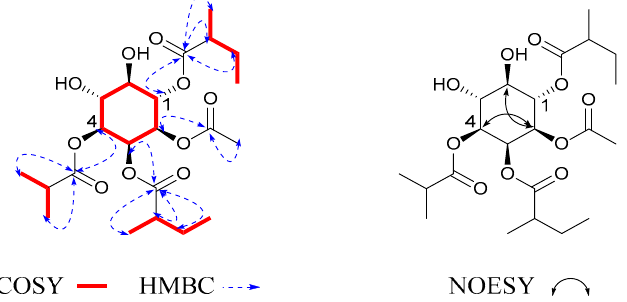
Figure 2. 1 H- 1 H COSY, key HMBC and NOE correlations of compound 1 . Compound 2 was obtained as a colorless solid. Its molecular formula, C 21 H 34 O 10 , was determined by positive HR-ESI-MS at m / z 464.2498 [M + NH 4 ] + (calcd. 464.2496) with five degrees of unsaturation. The downfield chemical shifts of H-1 at δ H 5.33 (1H, t, J = 10 Hz), H-2 at δ H 5.08 (1H, dd, J = 10.0, 2.8 Hz), H-3 at δ H 5.55 (1H, t, J = 2.8 Hz), H-4 at δ H 4.89 (1H, overlap), H-5 at δ H 3.84 (1H, t, J = 10 Hz), and H-6 at δ H 3.56 (1H, t, J = 10 Hz) also suggested that 2 possesses a 1,2,3,4-tetra-substituted inositol ring as in 1 . Through 1 H- 1 H COSY and HMBC (Figure 3) spectra, the correlation from H-1 to C-iBu indicated that the iBu was attached to C-1; the correlation from H-2 to C-iBu ′ indicated that the iBu ′ was attached to C-2; the correlation from H-3 to C-2MB indicated that the 2MB was attached to C-3; the correlation from H-4 to C-Ac indicated that the Ac was attached to C-4. The relative configuration was determined by the same method as that used for 1 . The NOESY correlations of H-1/H-5 demonstrated that the relative configuration of H-1/H-5 was determined as α . Therefore, compound 2 was determined to be myoinositol-1,2-isobutyryloxy-3-(2-methylbutyrate)-4-acetate, and was named solsurinositol B.